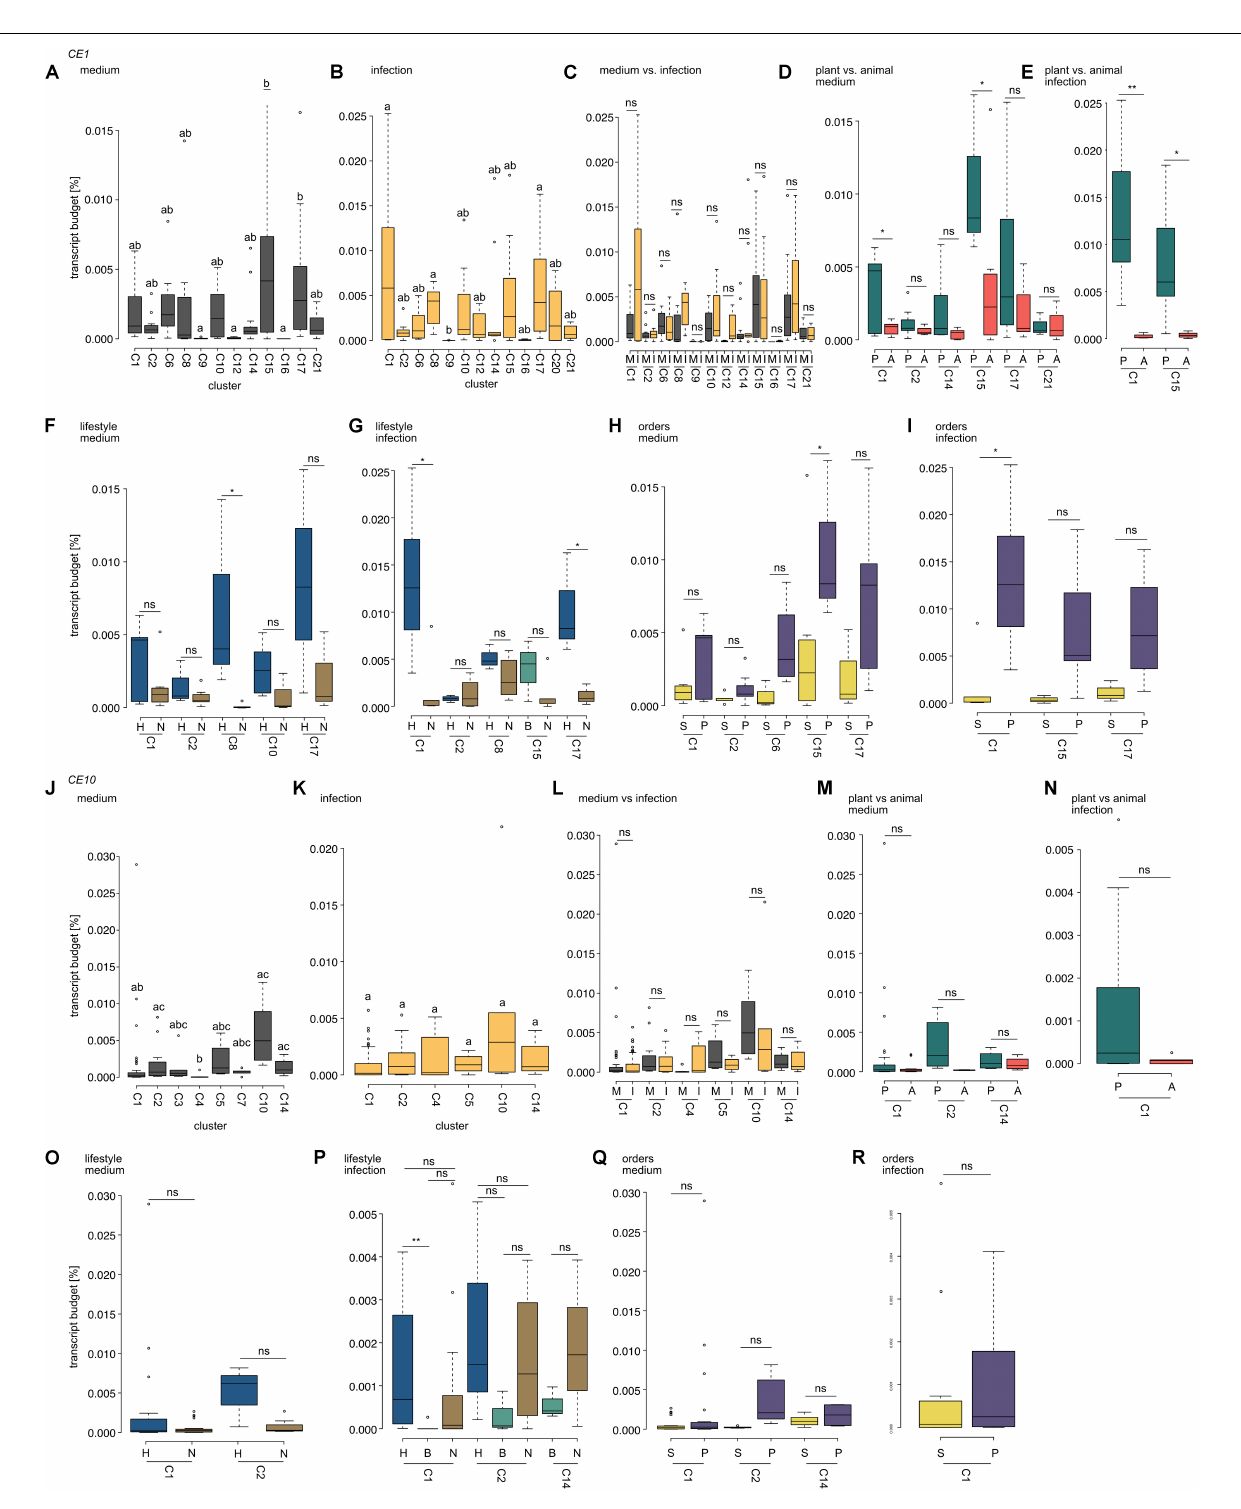
FIGURE 6 | Comparison of expression levels of carbohydrate esterase 1 (CE1)- and 10 (CE10)-coding genes. Box plots show the transcript budget (relative to the overall expression level; calculations are based on TPM) that oomycetes invested into CE1- (A–I) and CE10-coding genes (J–R) . All cluster assignments are based on the phylogenies shown in Figure 3 (CE1) and Figure 4 (CE10). (A,B,J,K) Compare expression levels between the different clusters of the CE families analyzed for growth on plate (medium) and growth on a host (infection). Different letters indicate significant differences in expression levels ( p < 0.05). (C,I) Show the